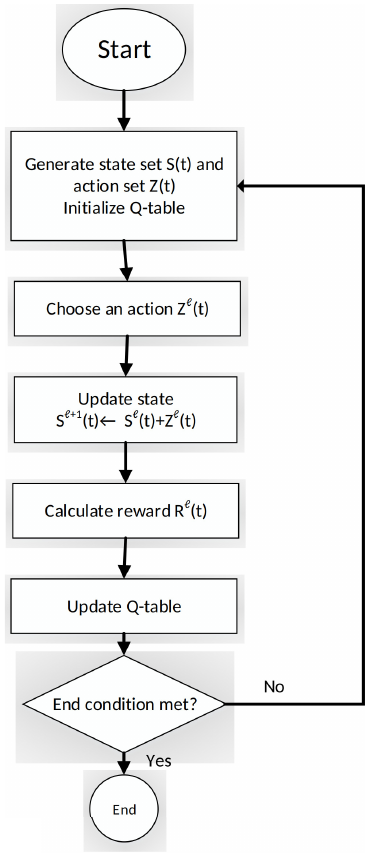
Figure 6. Flowchart of the proposed QLRA